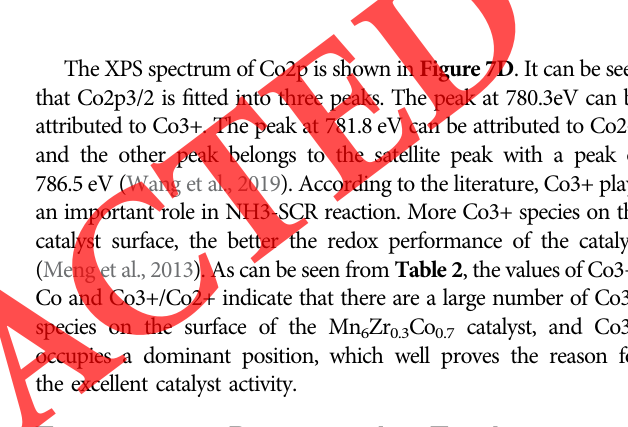
FIGURE 8 | (A) NH 3 -TPD pro fi les of Mn 6 Zr 1 and Mn 6 Zr 0.3 Co 0.7 catalysts and (B) H 2 -TPR pro fi les of Mn 6 Zr 1 and Mn 6 Zr 0.3 Co 0.7